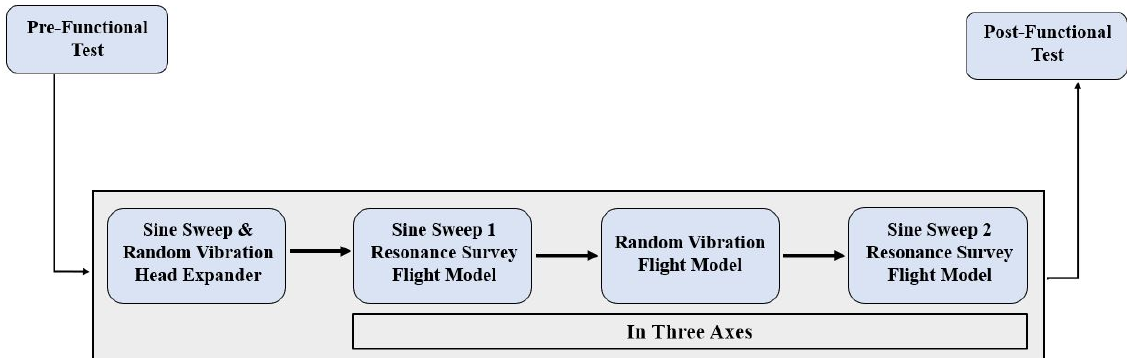
Figure 19. Test pod mounted on the head expander.